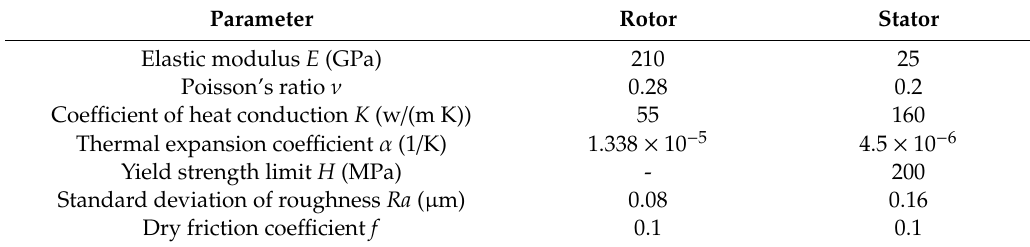
Table 3. Material properties of seal rings.